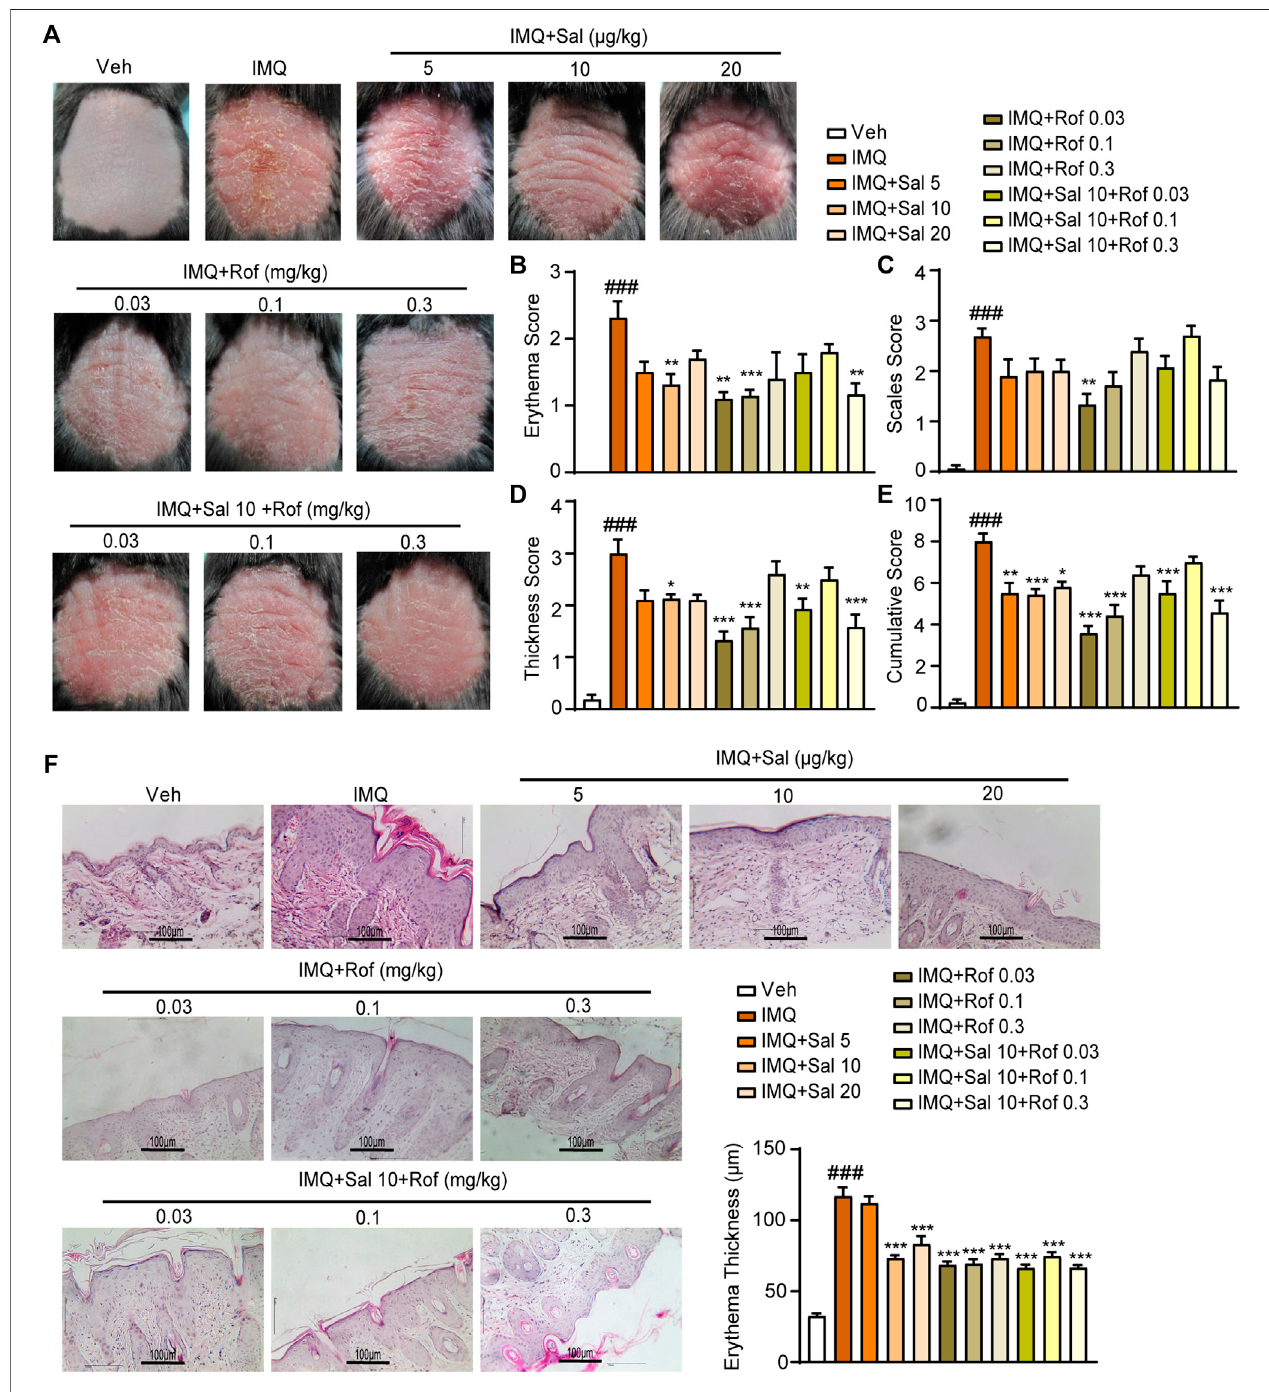
FIGURE5| Effectsofsalmeterol,ro fl umilast,andsalmeterolcombinedwithro fl umilastonpsoriasis-likedermatitisinducedbyIMQinmice.Psoriasis-likedermatitis wasinducedbyIMQinmice.Sal,Rof,andthecombinationofSalandRofweresubcutaneouslyadministered undertheskinfor5 days. (A) Macroscopicpresentationof miceonthesixthdayafterIMQtreatment. (B – E) QuantitativeseverityassessmentonthesixthdayafterIMQtreatment( n =5 – 8).Erythema (B) ,scales (C) ,andthickness (D) of the back skin were scored on a scale from 0 to 4. The cumulative score (E) was calculated. (F) Representative H&E staining of cross-sectional slices of the backskinonthesixthdayafterIMQtreatment.Theepidermalthicknessofthedorsalskinwasmeasured by fi verandomlyselected fi eldspersectionofeachmouse.( n = 5 – 8; ×200, Scale bar = 100 μ m).Dataare presented asthe mean ± SEM. ### p < 0.001 vs. vehicle group; * p < 0.05, ** p < 0.01, and *** p < 0.001 vs. IMQ-treated group by one-way ANOVA followed by Tukey ’ s post-hoc